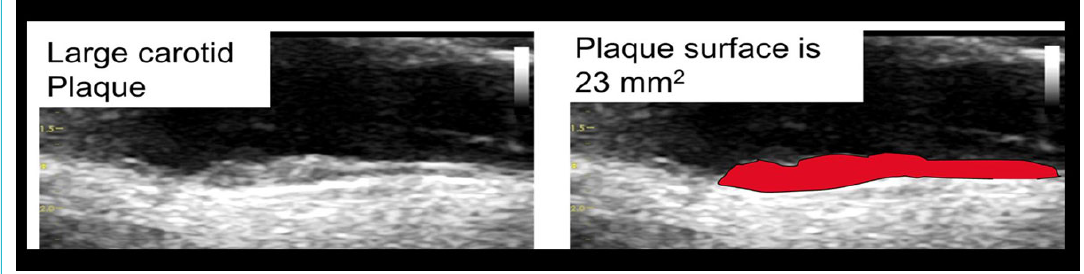
Figure 7: Clinical significance of plaque measurements by integration of the Bayes theorem. A plaque area of 23 mm 2 (see fig. 6) cor- responds to an arterial age of 34 years in men and 43 years in women. An arterial age of 70 years corresponds to a total plaque area (TPA) of 108 mm 2 in men and 66 mm 2 in women, with increased risk [112]. On the basis of data from the Tromsø study, an arterial age of 70 years cor- responds to the 96th percentile in men (sensitivity 9%, specificity 97%) and to the 95th percentile in women (sensitivity 18%, specificity 95%). According to the Bayes theorem, a person with a 4% risk and arterial age of 70 would then be reclassified to intermediate risk (men 11%, women 13%). For a 10-year risk of 10%, an arterial age of 70 would increase the risk to 25% in men and 29% in